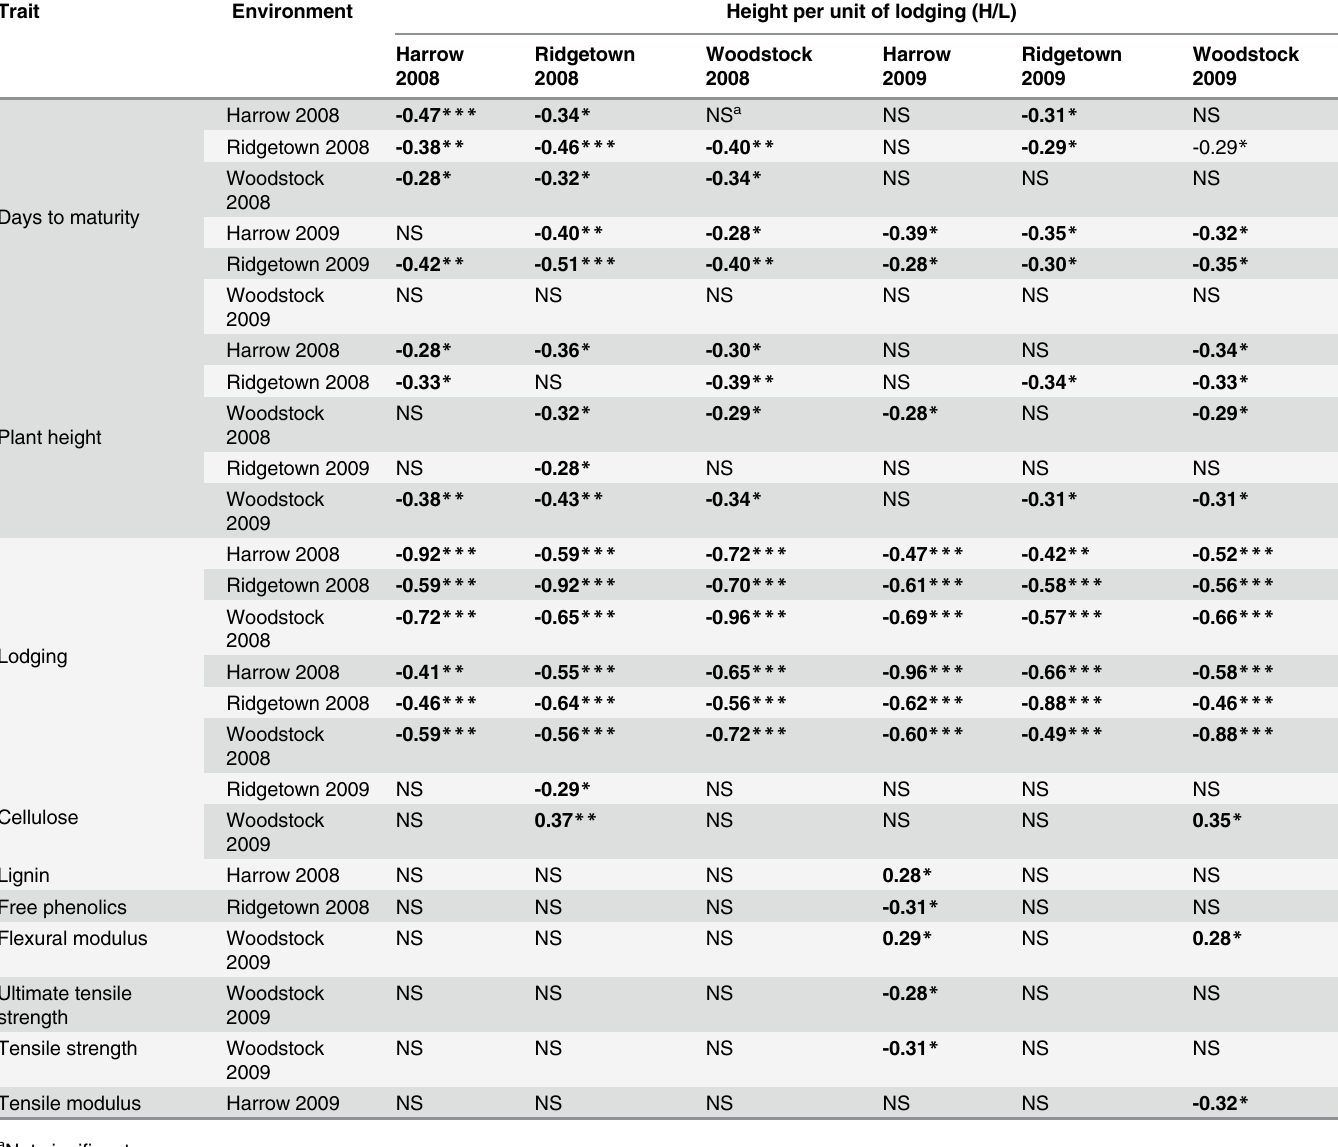
Table 3. Significant correlations between height per unit of lodging (H/L) and agronomic, fiber compositional and composite mechanical traits in 50 selected RG10 x OX948 recombinant inbred lines (RILs) in different environments.